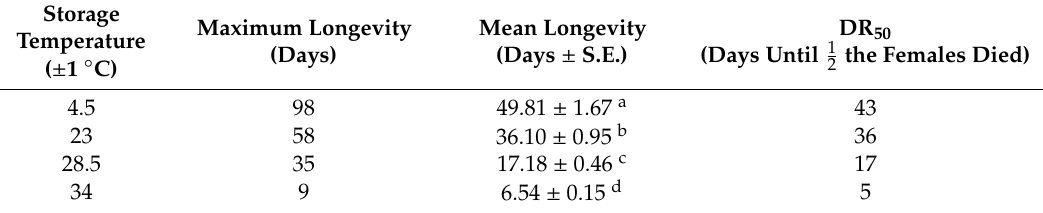
Figure 3. Sclerodermus brevicornis adult female longevity at di ff erent temperatures. Fitted curves were estimated using parametric cohort survival analysis including age dependence (estimated shape parameter α = 2.87; estimated rate parameters: 4.5 ◦ C = 0.00000842; 23 ◦ C = 0.000025219; 28.5 ◦ C = 0.000208744; and 34 ◦ C = 0.0036849) with the number of females alive on a given day calculated as = 200 × (antiLog e ( − (Rate × Day α ))). Table 3. Longevity of starved S. brevicornis females stored at di ff erent temperatures.